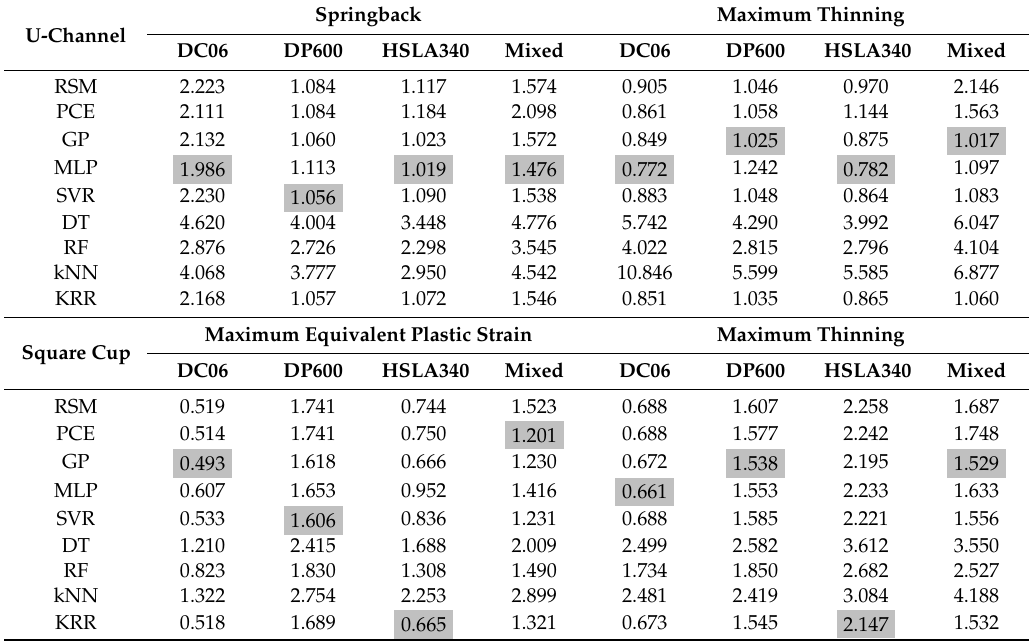
Table 2. Values of root mean square relative error (RMSRE, %) obtained for the metamodel prediction for the U-Channel and Square Cup